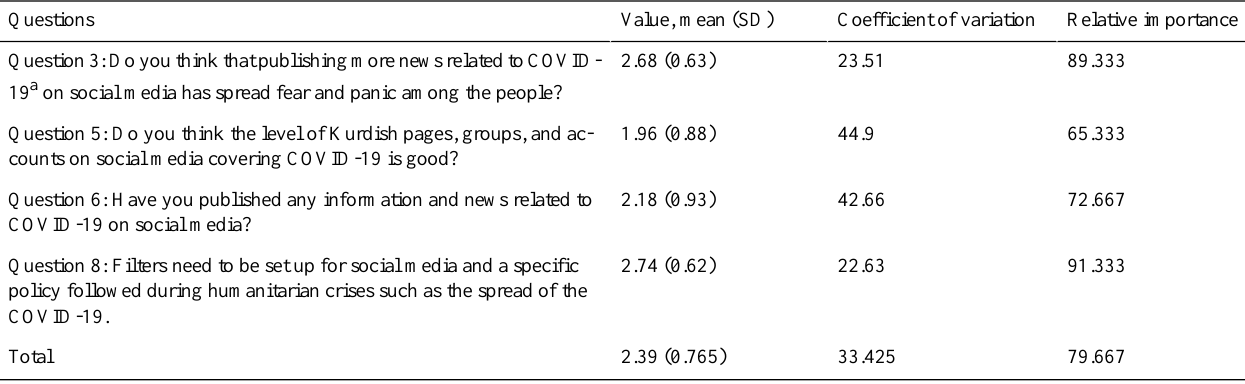
Table 4. Descriptive statistics of questions.